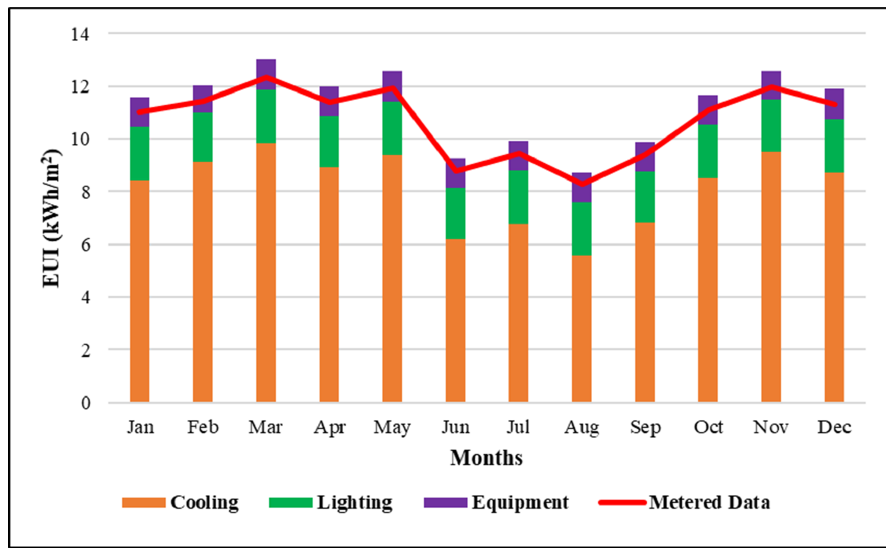
Figure 6. Validation of base model building